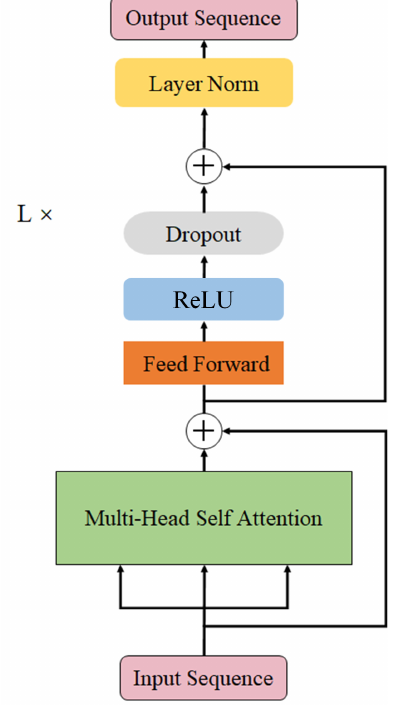
Figure 2. The Transformer Encoder module in this paper.